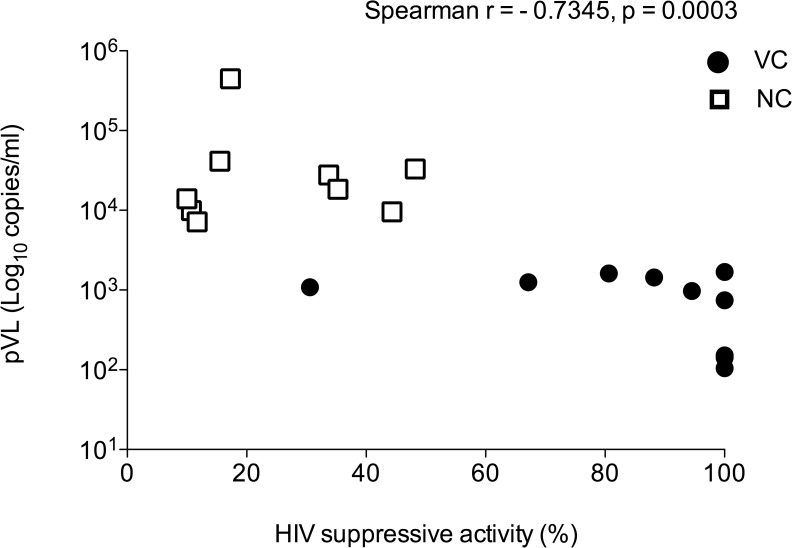
Correlation between HIV suppressive activity and pVL.
In vitro HIV suppression assay mediated by ex vivo unstimulated CD8+ T cells at E:T ratio of 1:1 from HIV-infected volunteers (N = 19) were shown on the X-axis as percentages of HIV suppression. The pVL at the same time-point as the HIV suppression assay are presented on the Y-axis. Each symbol represents a single HIV-infected volunteer. Filled circles and open rectangles represent viraemic controllers and noncontrollers, respectively. Spearman’s rank test was analyzed as the statistic.